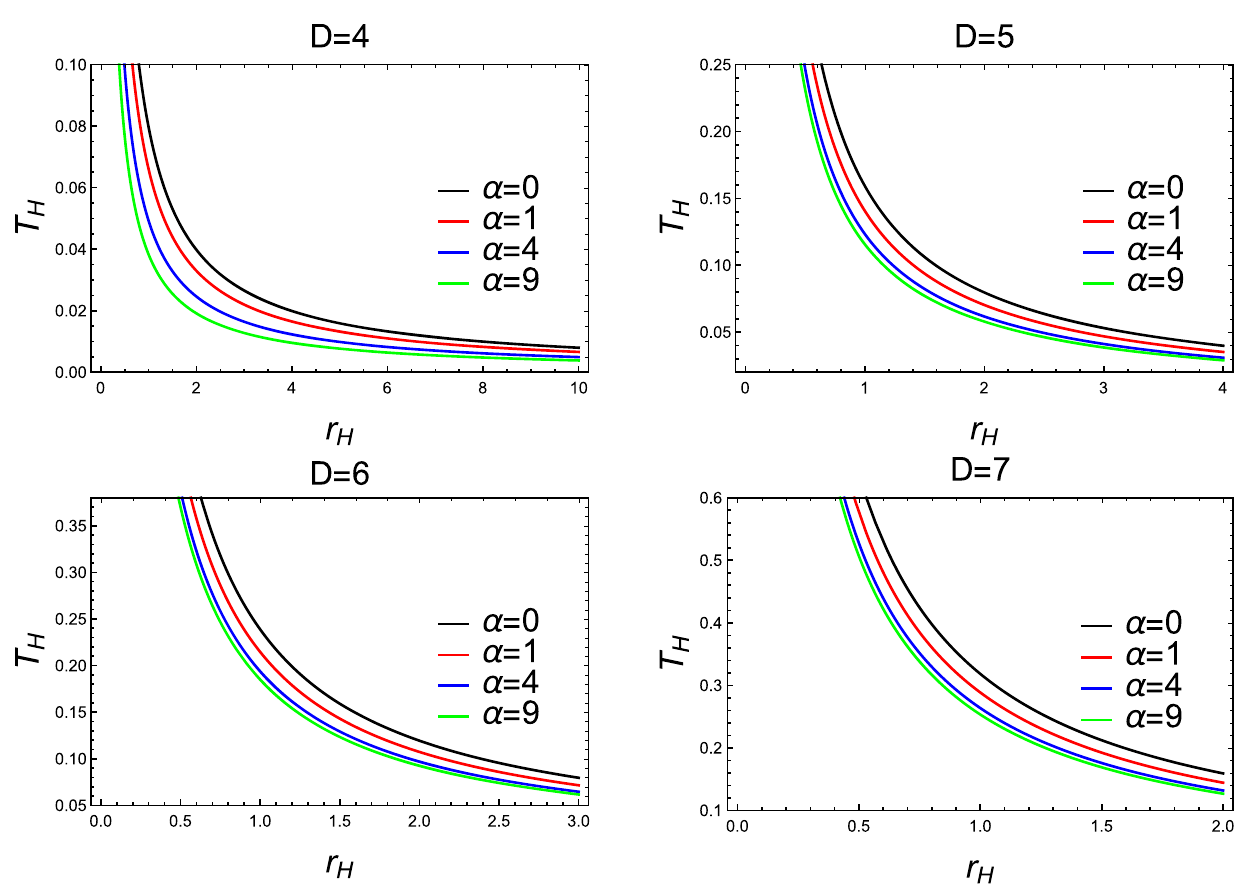
Fig. 2 Hawking temperature T H with respect to r H for different values of α , where the spacetime dimension is taken to be D = 5 , 6 , 7, respectively, and the case of D = 4 is attached for